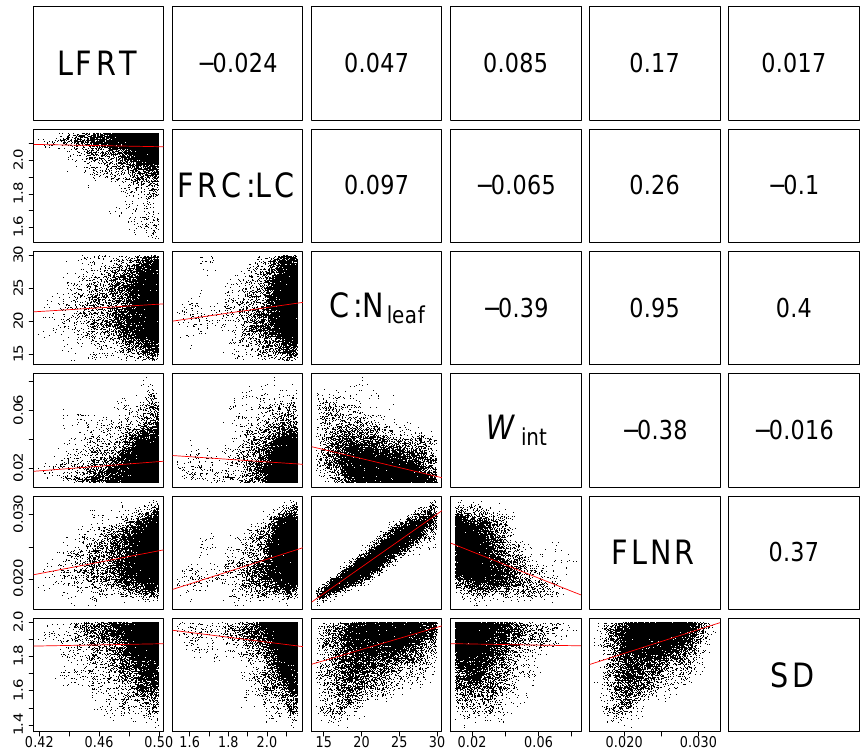
Figure 3. Correlation coefficient and scatterplot between the posterior distributions of each pair of calibrated Biome-BGC parameters ob- tained from Experiment 1. Information about the Biome-BGC parameters is given in Table 1. SD is the effective soil rooting